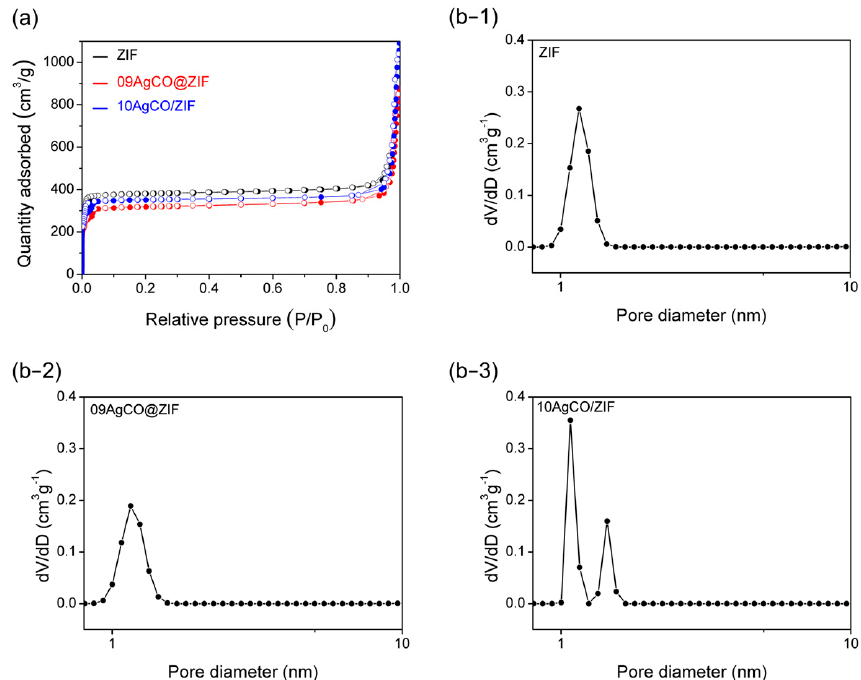
Figure 7. ( a ) N 2 adsorption/desorption isotherm, and pore size distribution ( b − 1 ) ZIF (as-synthesized ZIF-8), ( b − 2 ) 09AgCO@ZIF (de novo), ( b − 3 ) 10AgCO/ZIF (impregnation) samples.